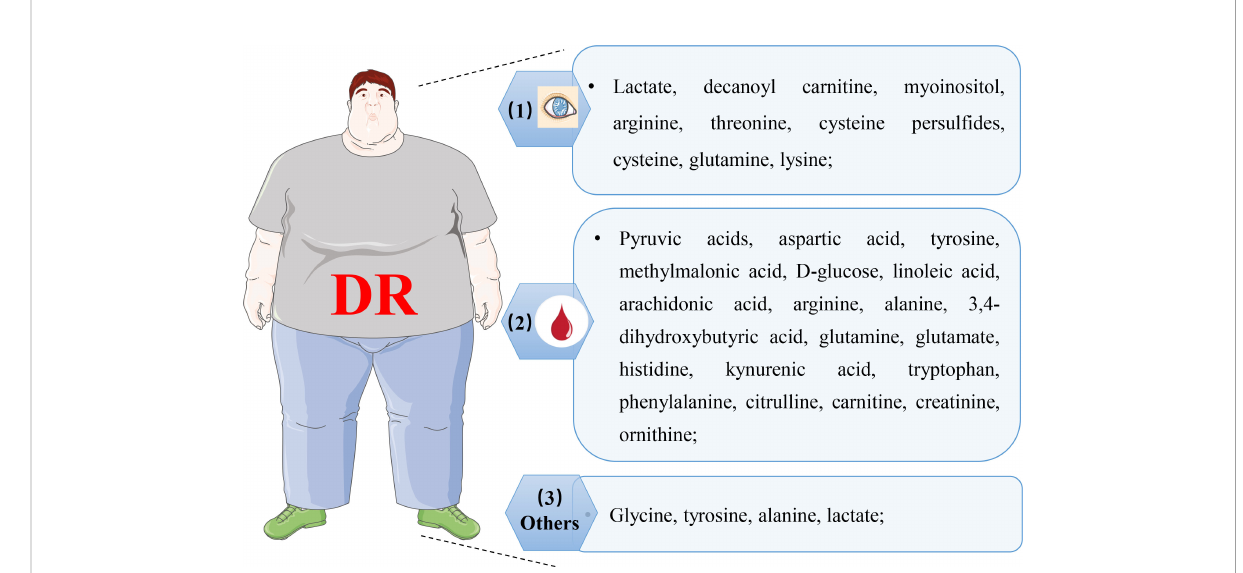
FIGURE 6 Representative of altered metabolites in various biological samples with DR. (1) representative of changed metabolites in retina, vitreous humor, and aqueous humor; (2) representative of altered metabolites in plasma and serum; (3) representative of altered metabolites in cerebrospinal fl uid, urine, and